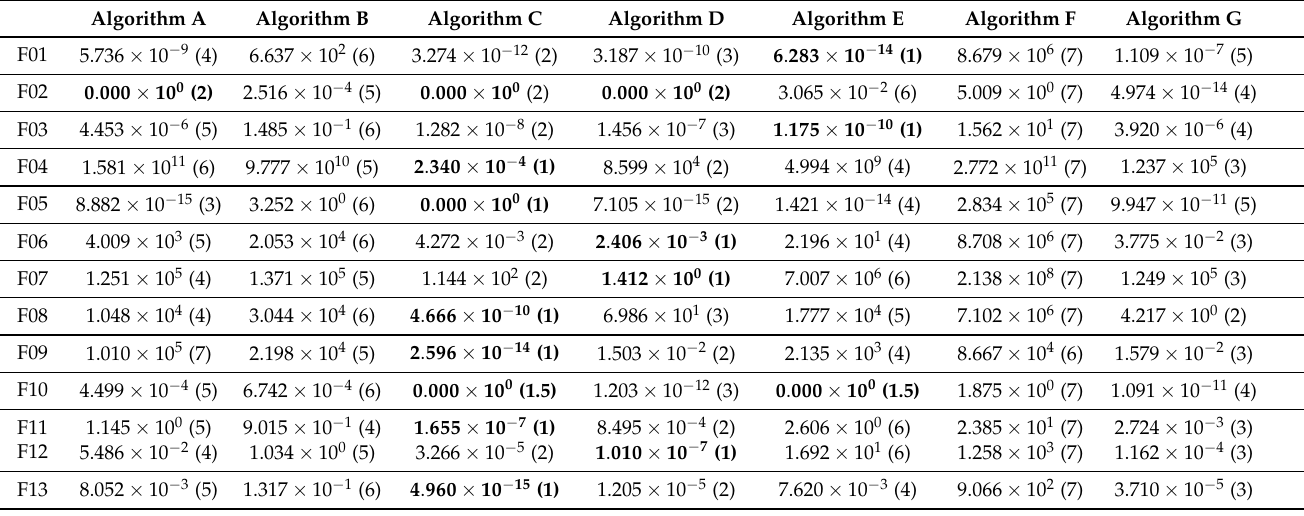
Table 8. Quantiles Q 0.10 of the obtained solution